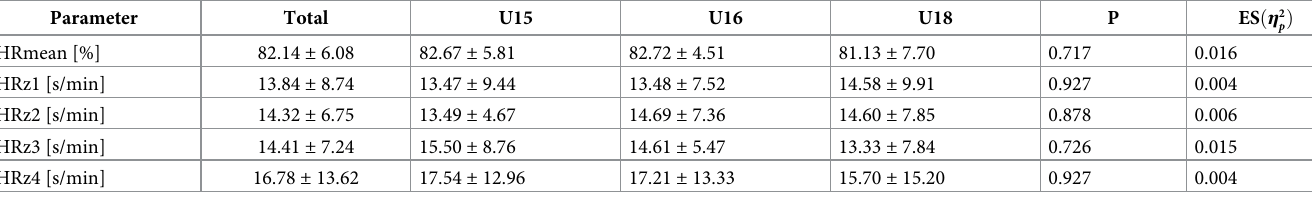
Table 2. Internal load parameter for the total training sessions, p-values and effect size.